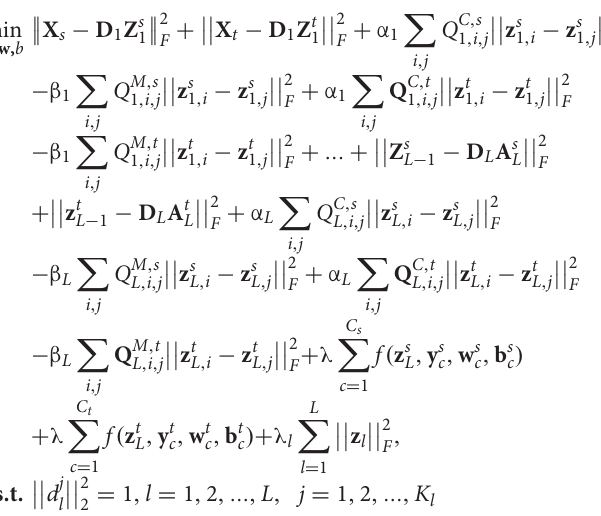
Normal images from the REMBRANDT dataset